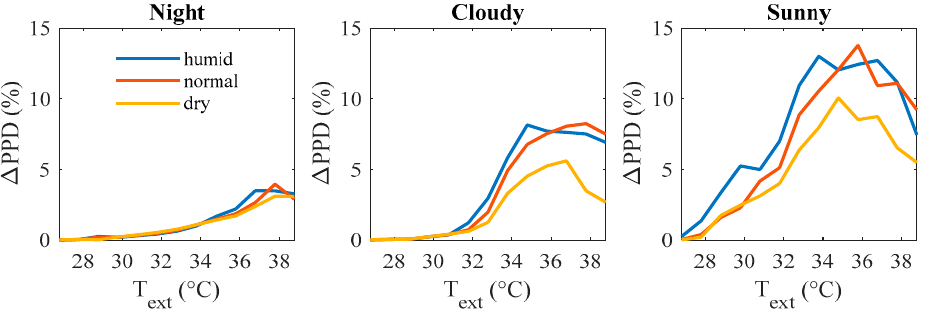
Figure 19. Mean PPD difference between DP and real-time control, for a given HVAC energy.